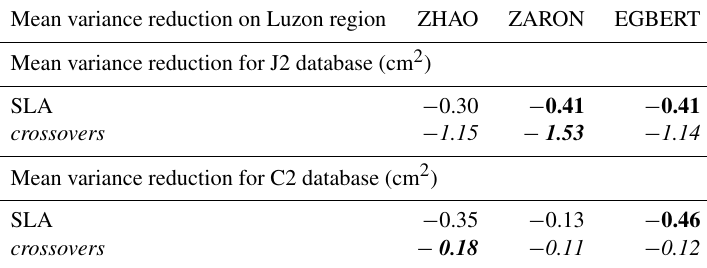
Table B1. Mean variance reduction for J2 and C2 altimeter databases, in the Luzon region, when using the different O 1 internal-tide models and compared to the ZERO correction case; variance reduction in altimeter SLA (white lines) and for altimeters crossover differences (italic lines) for each mission, in square centimeters. The maximum variance reduction across the different models is highlighted in